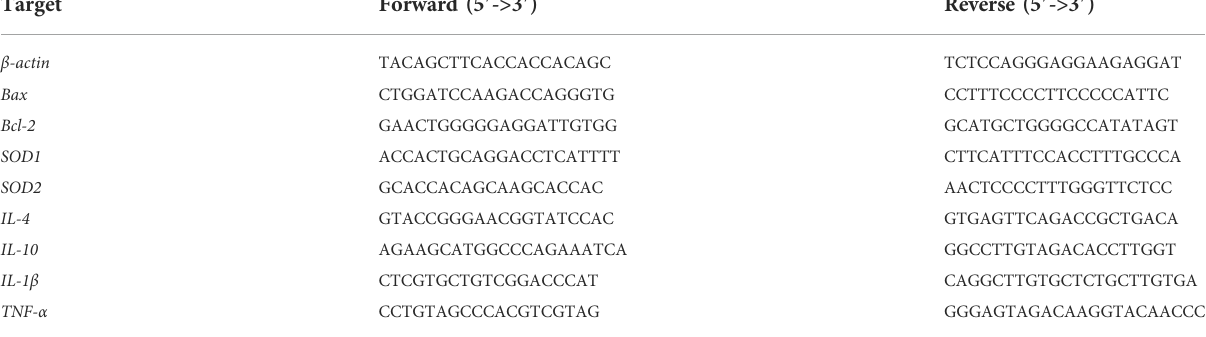
TABLE 1 List of primer used in this